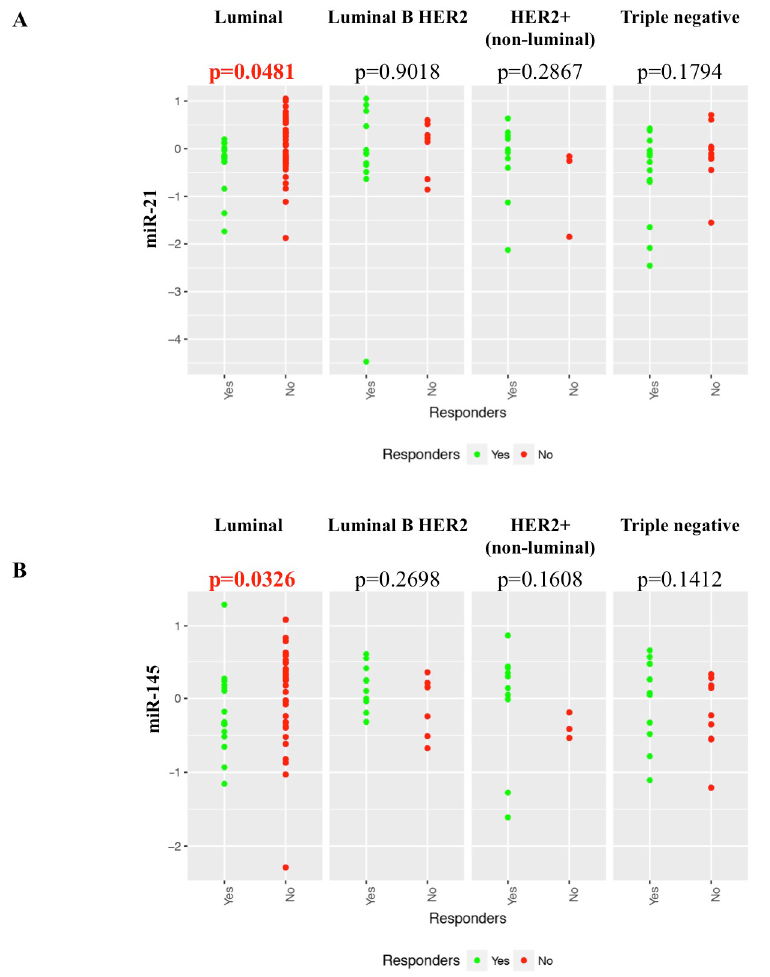
Figure 4. Variation in levels of each target miRNA by response to NACT was assessed in the four breast cancer subtypes. ( A ) miRNA-21 patients with low levels had a higher response rate in Luminal cancers. ( B ) miRNA-145 patients with low levels had a higher response rate in Luminal cancers. Luminal (responders n = 15, non-responders n = 41), Luminal B Her2 (responders n = 12, non-responders n = 7), Her2+ (non-luminal) (responders n = 10, non-responders n = 3), Triple negative (responders n = 14, non-responders n = 9). p < 0.05 considered significant.